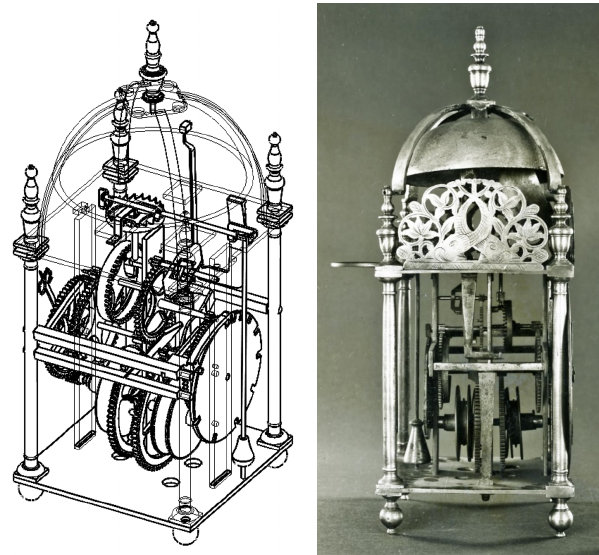
Figure 27. N10 – Lantern clock (James Markwick) (British Museum, 2020d).